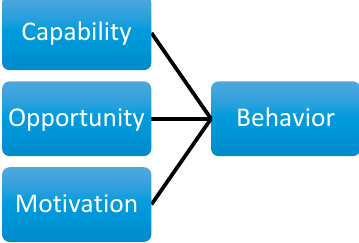
Figure 1. The original construct of COM-B model for behavioral change [11,16,21].